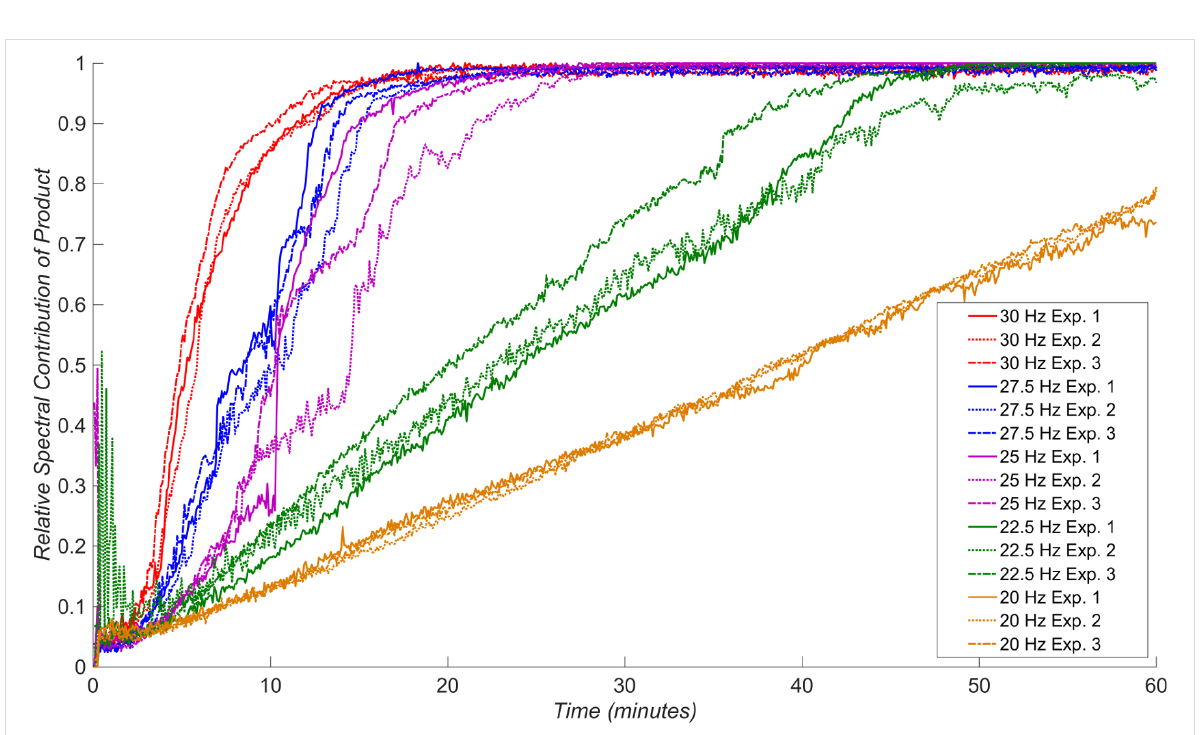
Figure 5: The reproducibility of varying milling frequency on the neat mechanochemical condensation of benzil and o- phenylenediamine, as measured by triplicate